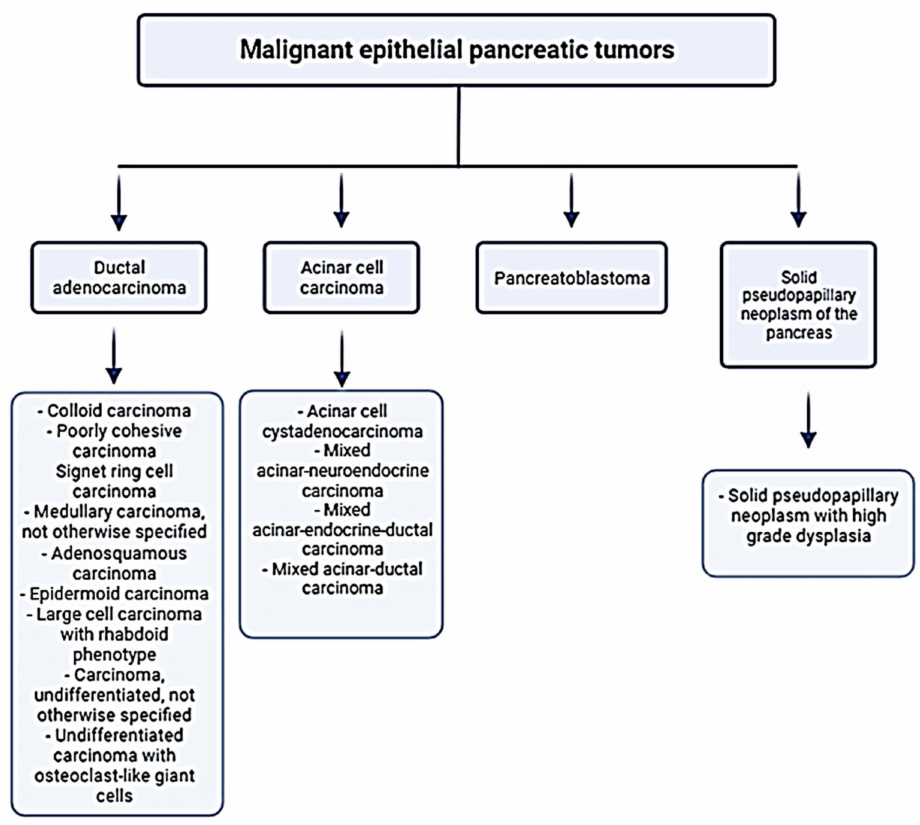
Figure 1. WHO classification of malignant epithelial pancreatic tumors